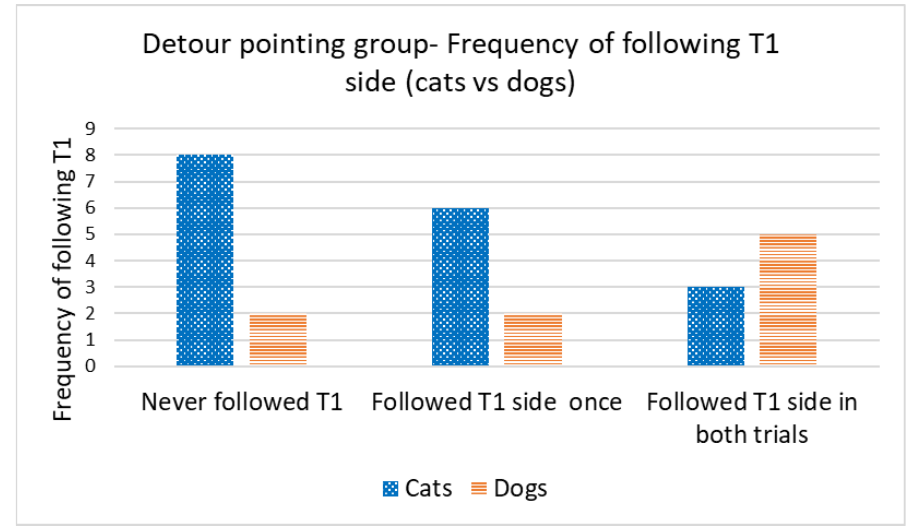
Figure 6. Detour-pointing group: frequency of following the same side as in Trial 1, during Trial 2 and Trial 3 (cats vs dogs). and Trial 3 (cats vs.